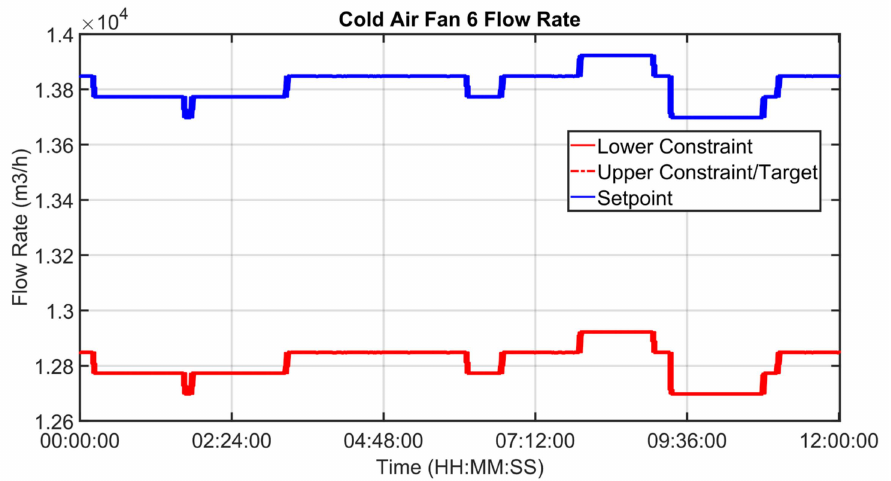
Figure 33. Grate cooler APC system: field results (cold air fan 6 flow rate